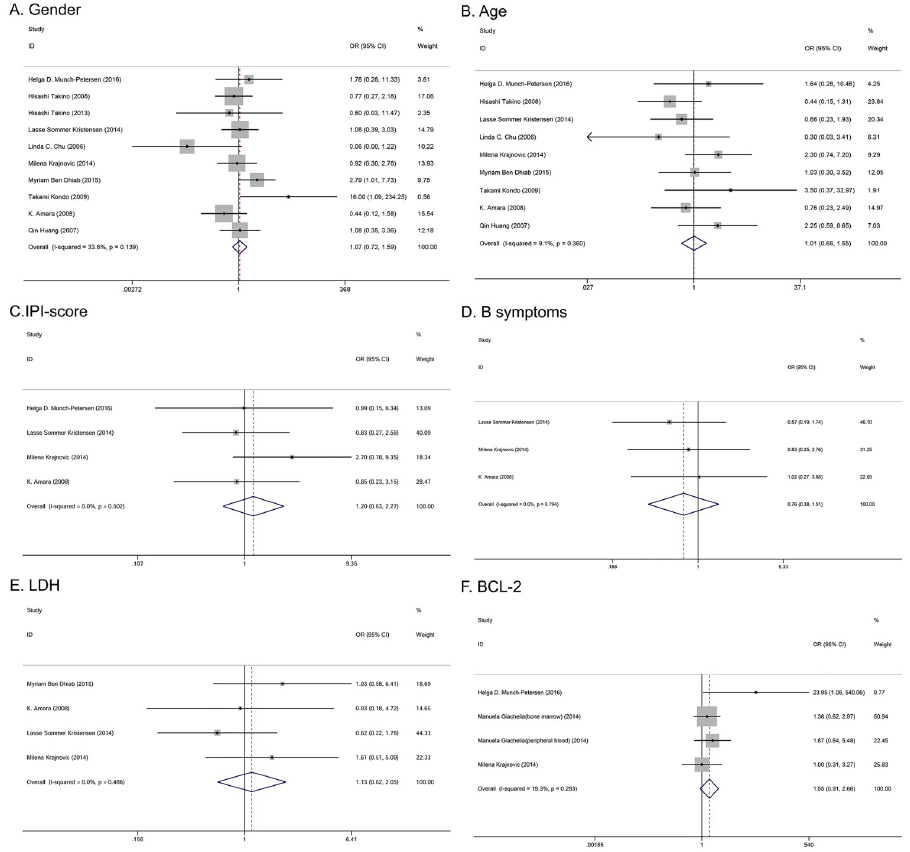
Fig 3. Association of DAPK methylation with clinical features of lymphoma. (A) Gender (B) Age (C) International prognostic factor (IPI) (D) B symptoms (E) Serum lactate dehydrogenase (LDH) (F) BCL-2 expressions.